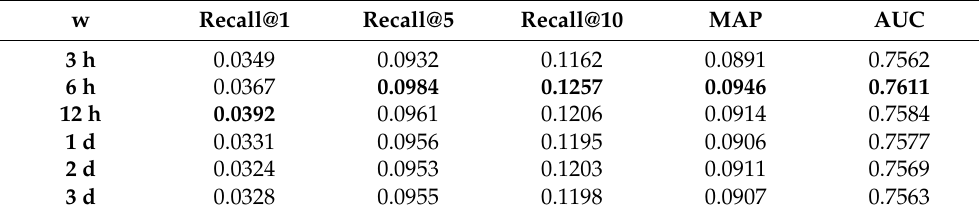
Table 2. Performance of MST-RNN with varying window width w evaluated by recall, F1-score, MAP, and